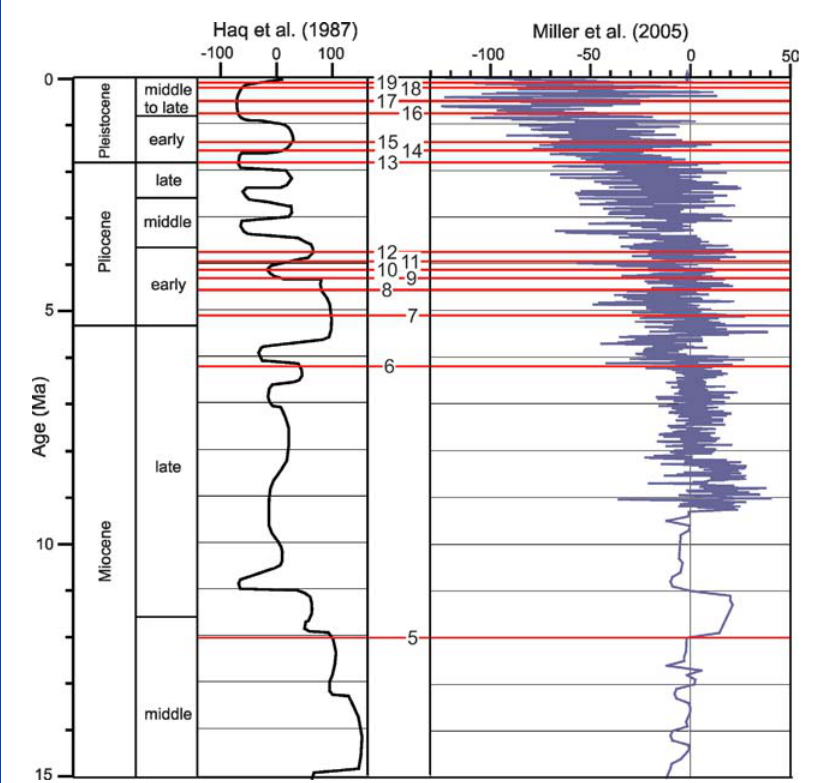
Figure 4. Global sea-level curves of Haq et al. (1987) and Miller et al. (2005) from the middle Miocene to Recent. Unconformities U5 to U19 are labeled and shown as red lines (shipboard ages are approximate). Note that much of the upper part of the Pliocene section is missing at Expedition 317 sites and a 5-My hiatus occurs in the upper Miocene, accounting for the large time gaps between some unconformities. Prior to 9 Ma, the Miller et al. (2005) curve is derived from backstripping of New Jersey MAT sites. However, the record since 9 Ma is a benthic foraminiferal (cid:2) 18 O record, calibrated to represent eustasy, because the MAT record there is